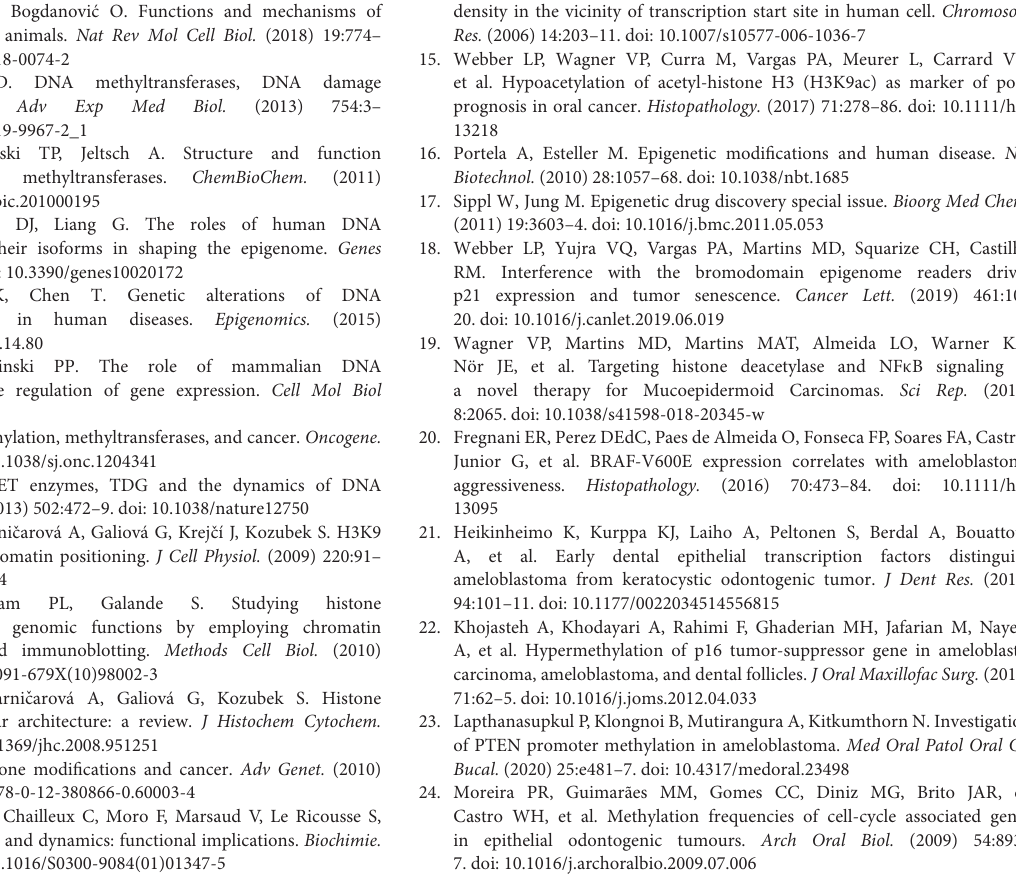
Supplementary Figure 1 | A AMEtma core sample before (A) and after application of Nuclear V9 software (B) , with DNMT3A reaction (DAB, ScanScope 15 × ). Graphic distributions of positive cells (%) for each antibody and categorical variable in AMEtma group. ∗ Statistical difference between groups